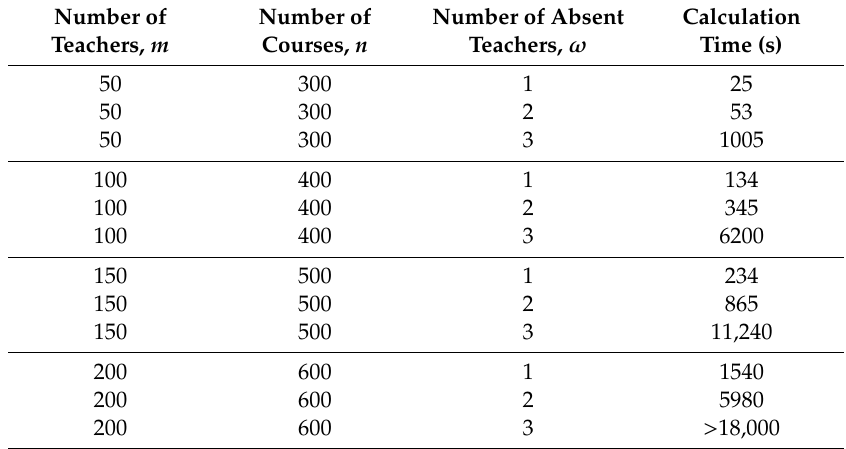
Table 12. Synthesis of competency framework, G OPT , guaranteeing full robustness ( R di ff erent numbers of teachers and